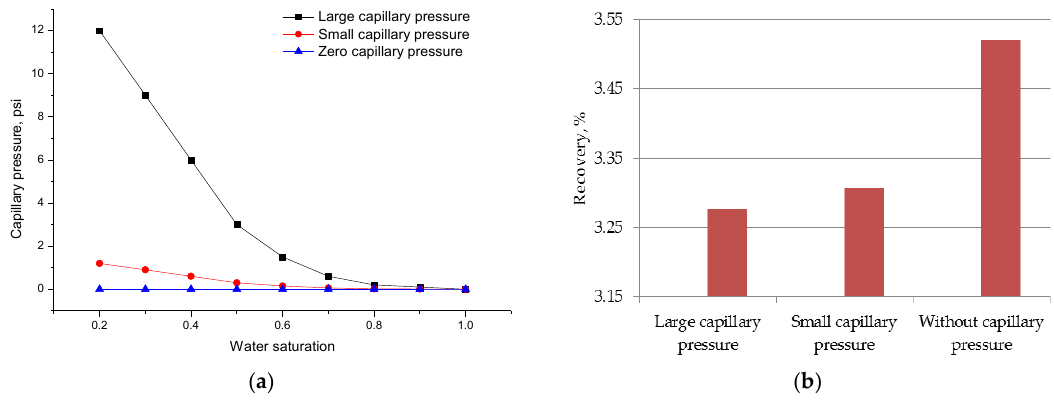
Figure 14. Simulation results for different capillary pressure. ( a ) Three capillary pressure curves ( b ) Recovery of different capillary pressure curves.